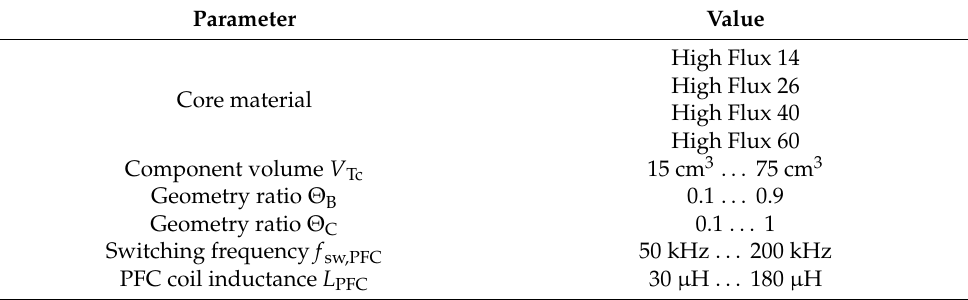
Table 4. Defined parameter space for PFC